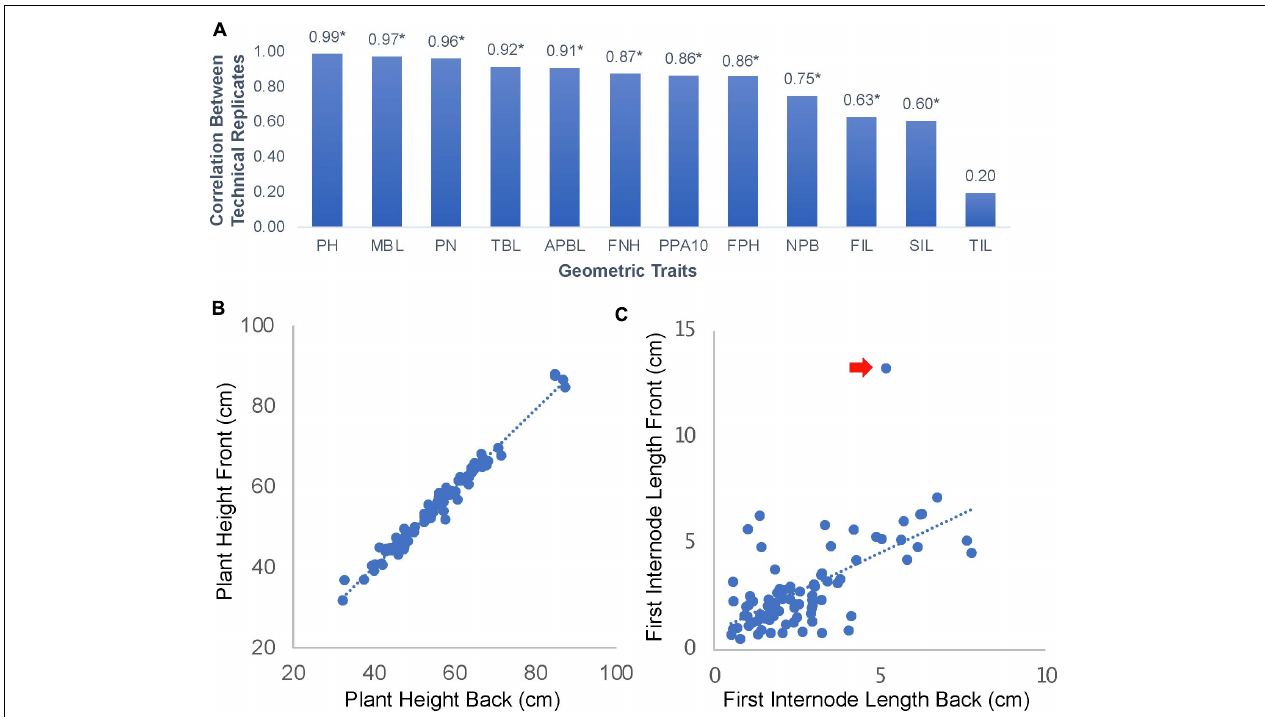
FIGURE 2 | Parameter correlations for images of edamame shoot architecture. (A) 12 geometric traits were measured in this study. PH, plant height; MBL, main branch length; PN, pod number; TBL, total branch length; APBL, average primary branch length; FNH, first node height; PPA10, percent of pod above 10 cm from ground; FPH, first pod height; NPB, number of primary branches; FIL, first internode length; SIL, second internode length; TIL, third internode length. Numbers on top of the bars are Pearson Correlation Coefficient (PCC). * indicates statistical significance ( p < 0.01). (B) Scatter plot of plant height measurement between technical replications (front and back images of the same plant). (C) Scatter plot of first internode length. Red arrow indicates an outlier data